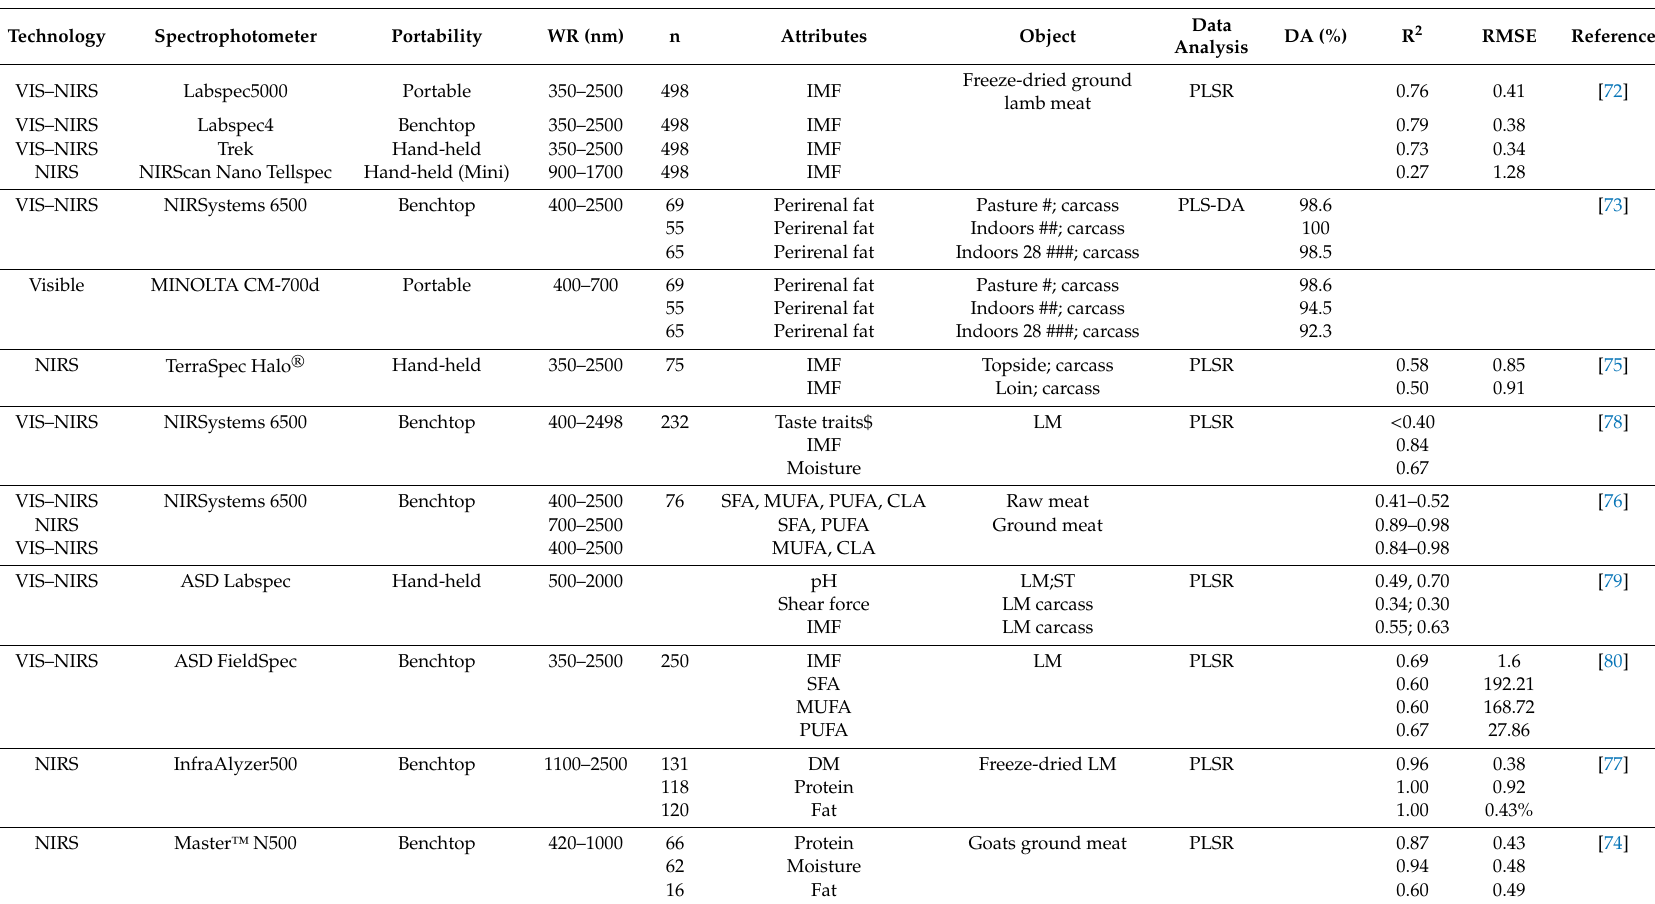
Table 5. Summary of the research using visible-near infrared spectroscopy (VIS–NIRS) and near infrared spectroscopy (NIRS) to assess meat quality of sheep and